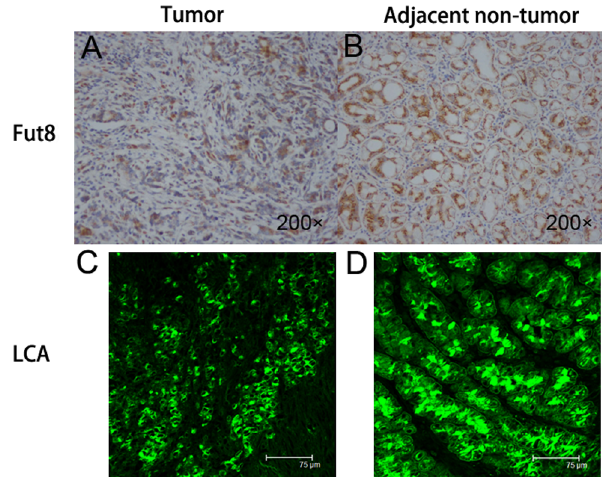
Figure 4. Immunohistochemical staining with Fut8 and lectin- histochemical staining with LCA in typical gastric tumor tissues and adjacent non-tumor tissues. (A) Immunohistochemical staining with Fut8 in tumor cells (200 6 ), the expression of Fut8 is weakly positive. (B) Immunohistochemical staining with Fut8 in non-tumor gastric cells (200 6 ), the expression of Fut8 is strongly positive. (C) Lectin-histochemical staining with LCA in tumor cells, bar 75 m m, the expression of LCA-binding core-fucosylated proteins is weakly positive. (D) Lectin-histochemical staining with LCA in non-tumor gastric cells, bar 75 m m, the expression of core-fucosylated proteins is strongly positive. doi:10.1371/journal.pone.0094536.g004 PLOS ONE |